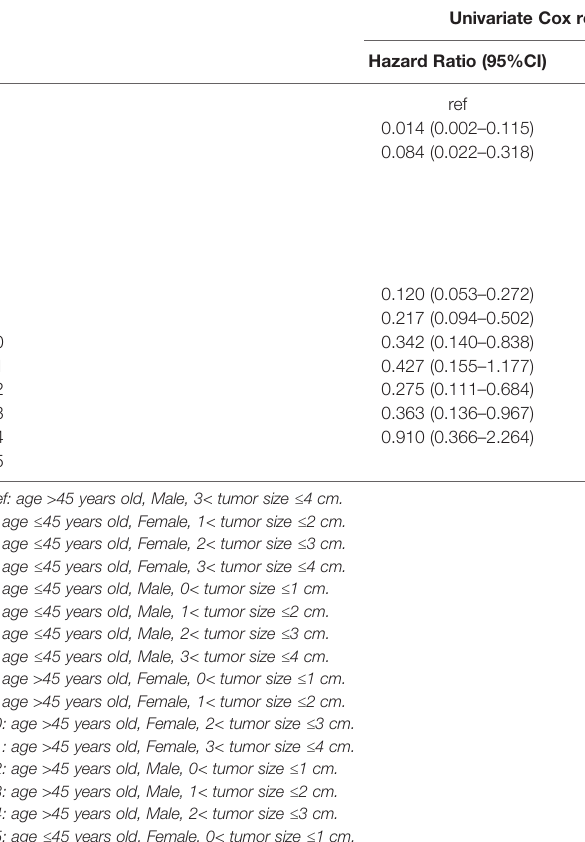
TABLE 3 | Age, sex, tumor size factors for survival: outcome of thyroid cancer speci fi c mortality and all-cause mortality.